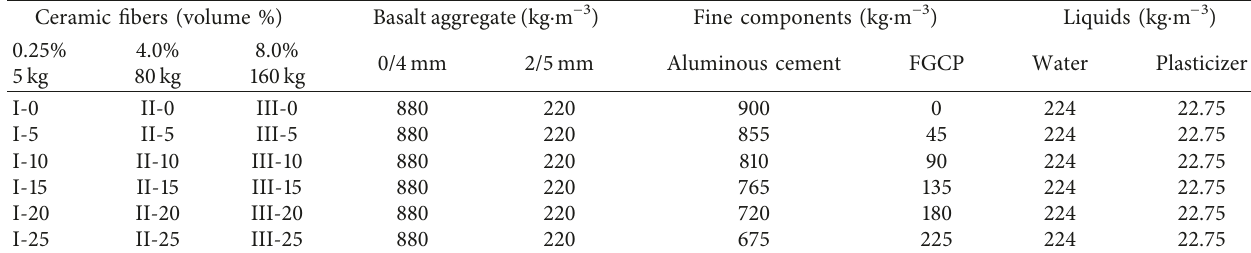
Table 2: Composition of studied